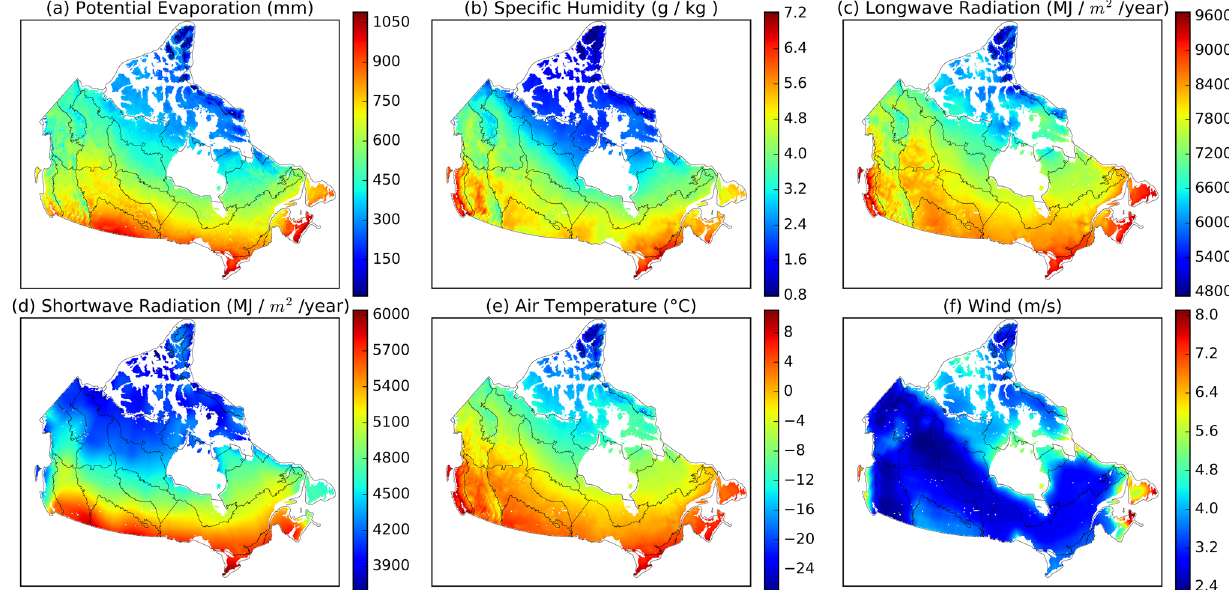
Figure 4. The spatial distribution of mean annual ( a ) potential evaporation (PE), ( b ) specific humidity (g/ kg), ( c ) downward longwave radiation (MJ/m 2 /year), ( d ) downward shortwave radiation (MJ/m 2 /year), ( e ) air temperature (°C), and ( f ) wind speed (m/s) in 1979–2016 in Canada (The black lines depict the spatial extent of each ecozone. The map was created using our own script in Anaconda Python 3.8 downloaded from https :// docs.anaco nda.com/anaco nda/insta